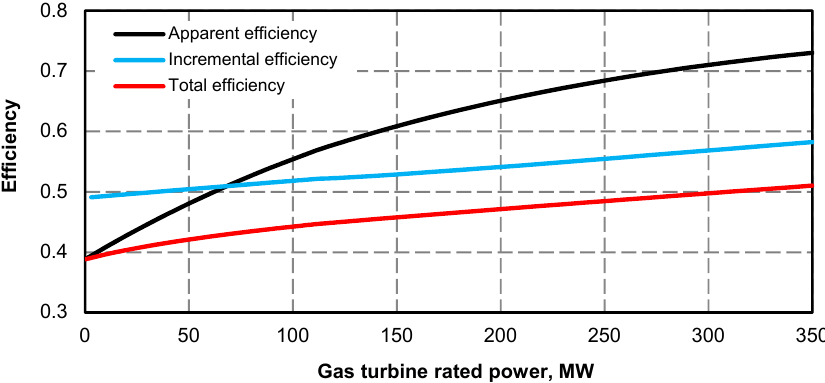
Figure 10. The energy efficiency for the power unit with superstructure added as a function of gas turbine rated power at a minimum steam boiler output of 133.3 kg/s and with gas turbine operating at its rated power.